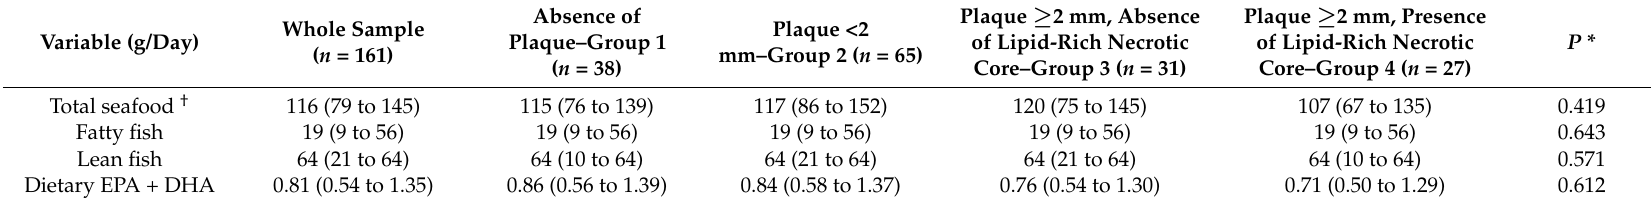
Table 2. Consumption of seafood products and their associated EPA + DHA